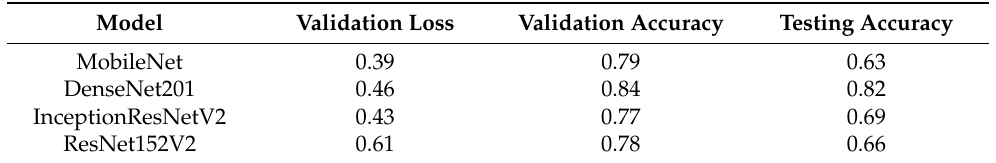
Table 5. Performance of the 4 best pretrained networks for binary classifier after fine tuning for a total of 15